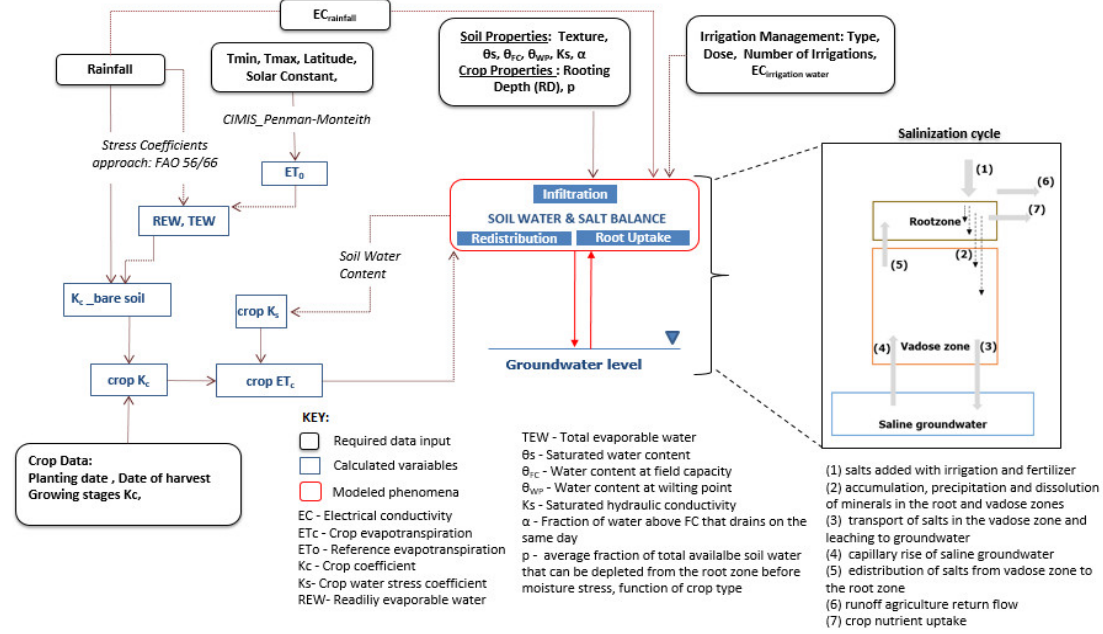
Figure 3. Main components of the soil–water and salinity balance model across the soil–water–plant– atmosphere–aquifer continuum.